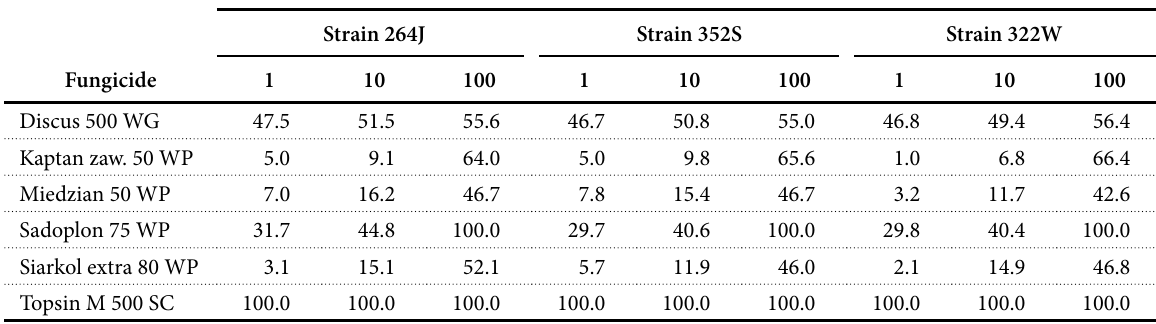
Small letters – differences among fungicides at a given concentration, p ≤ 0.05 (LSD = 1.48). Capital letters – differences among concentration at a given fungicide, p ≤ 0.05 (LSD = 0.84). Values marked with the same letter do not differ significantly.